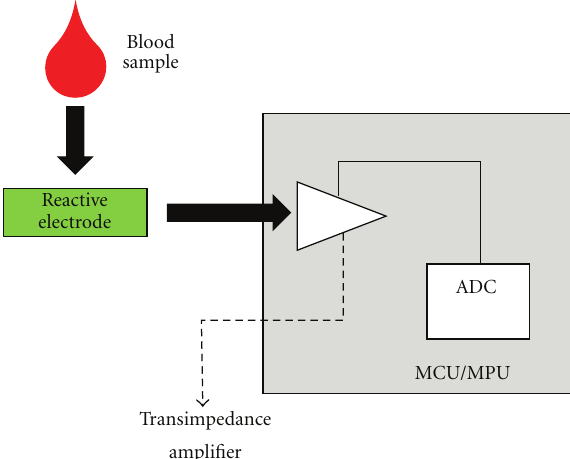
Figure 2: Test strip basic block diagram (http://www.eetimes .com/design/test-and-measurement/4204495/Blood-Glucose-Me-